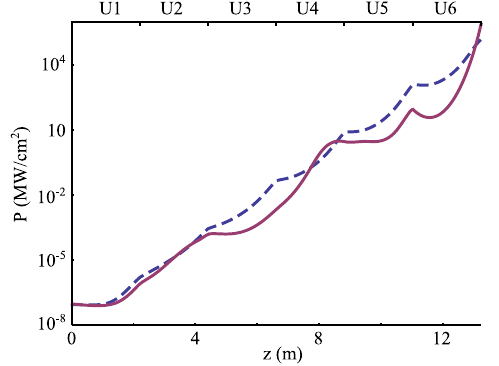
FIG. 3. An example of FEL intensity evolution along the undulator for the matched (blue dashed line) and transport (red continuous line) options in arbitrary units. The e-beam parameters at the linac exit are reported in Table I.